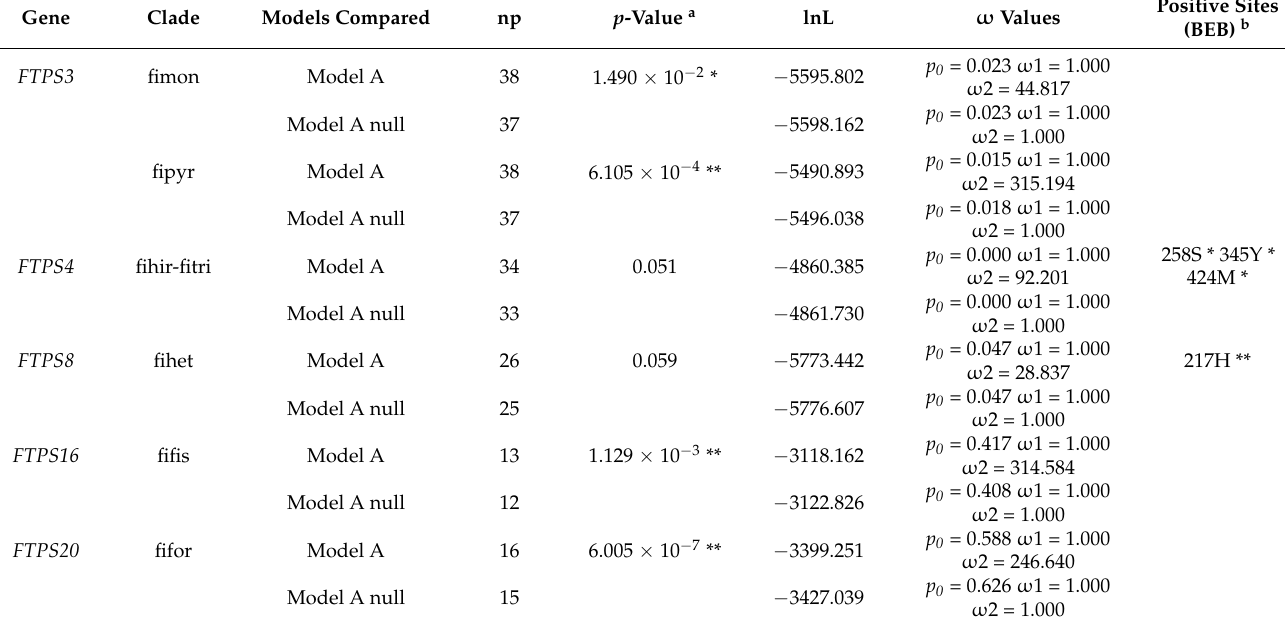
Table 3. Positive selection analysis of FTPS genes occurred in more than four species under branch site model